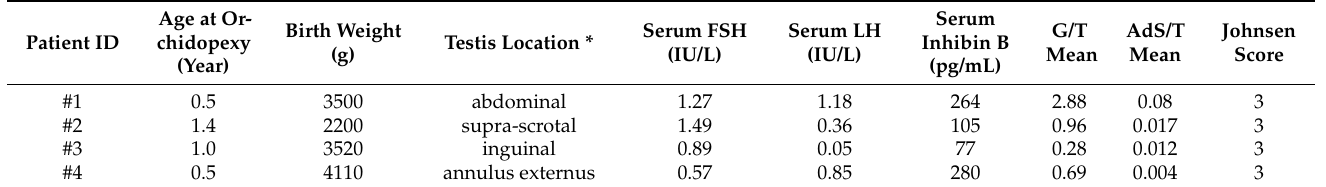
Table 1. Clinical and experimental parameters of infant boys with bilateral cryptorchidism.